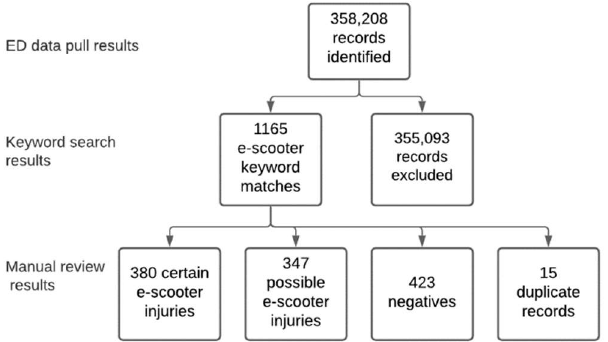
Figure 1. Results of the process used to identify e-Scooters from medical records.